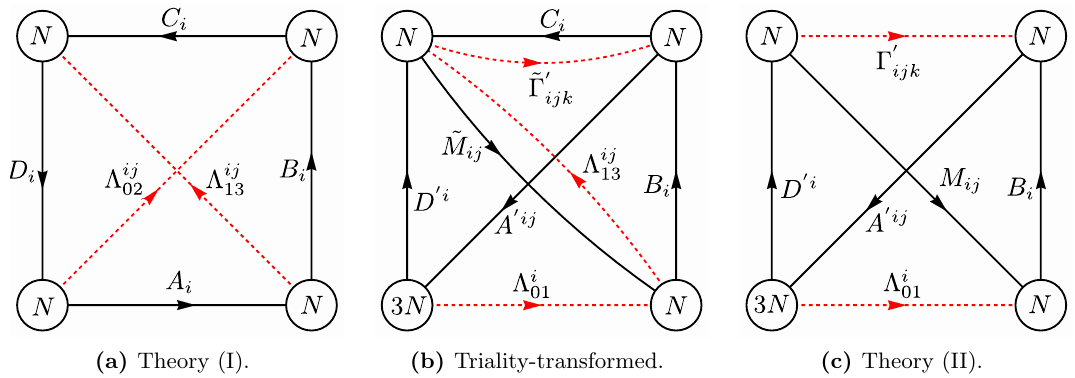
Figure 8 . A triality move on node e 0 (lower left) of Theory (I) gives the quiver shown in the middle. Integrating out the massive (cid:12)elds, which corresponds to cancelling fermi-chiral loops between pairs of nodes, we obtain Theory